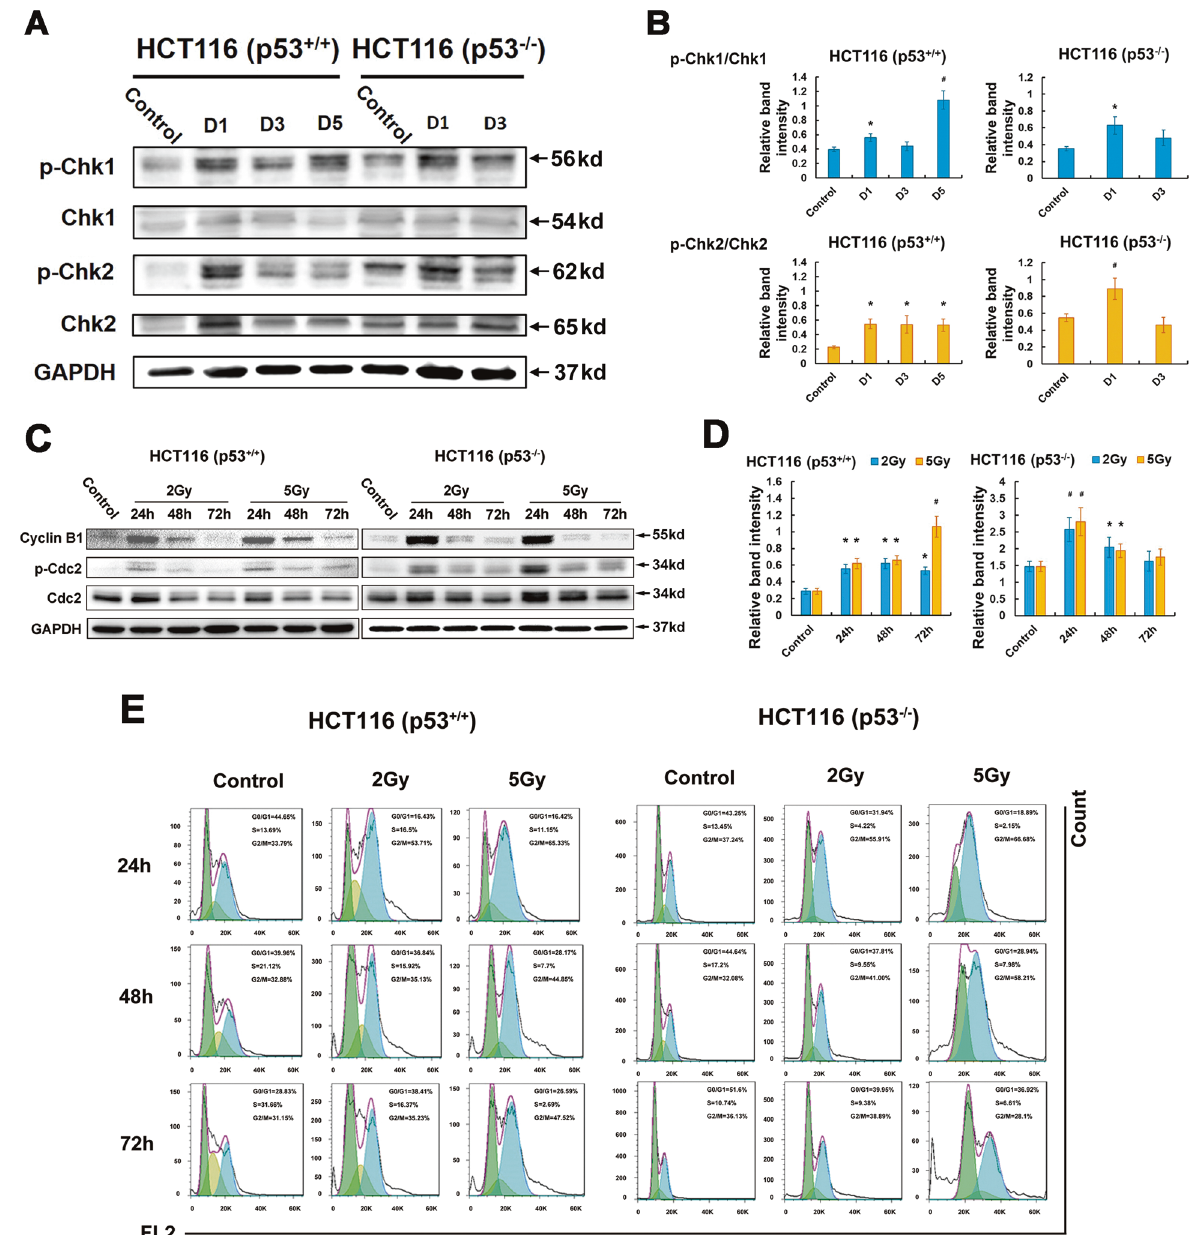
Fig. 2 Effect of CIR on the phosphorylation of Chk1, Chk2, and Cdc2 in irradiated p53 + / + and p53 − / − cells. A The relative band intensities for p-Chk1, Chk1, and for p-Chk2, Chk2. D represents Day. B The panel shows the relative band intensities for p-Chk1 and Chk1 and for p-Chk2 and Chk2. Blue columns and yellow columns indicate p-Chk1/Chk1 and p-Chk2/Chk2, respectively. Data are expressed as the mean ± SE. * p < 0.05; # p < 0.01. C G 2 -M checkpoint alteration in p53 + / + and p53 − / − HCT116 cells detected by immunoblots of Cyclin B1 and p-Cdc2 following 2 Gy and 5 Gy CIR. D The relative band intensities for p-Cdc2 and Cdc2. Data are expressed as the mean ± SE. * p < 0.05; # p < 0.01. E CIR-induced cell cycle arrest in p53 + / + and p53 − / − cells for 24, 48, and 72 h using fl ow cytometry. No less than 72 h prolonged arrest at G 2 -M phase was observed in p53 + / +